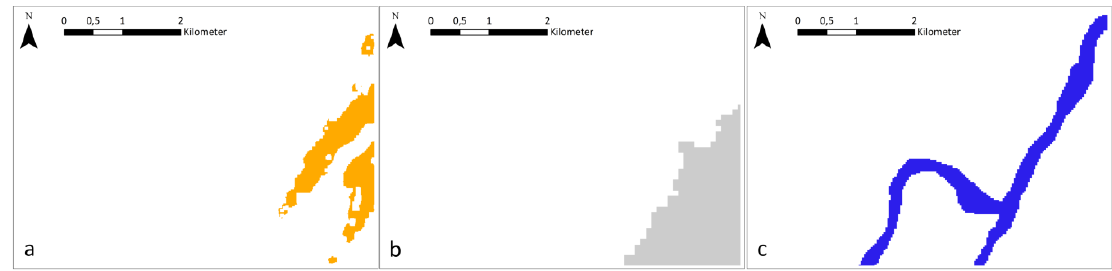
Figure 3. Additional information in the study area Namibia. Global Urban Footprint (GUF) ( a ), exclusion mask (threshold 20 m) of the height above nearest drainage (HAND) index ( b ), SRTM Water Body Data (SWBD) ( c ).